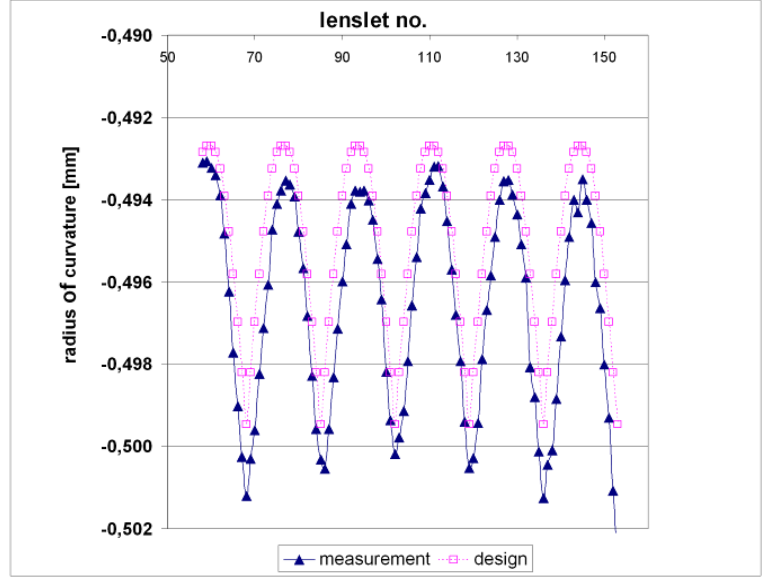
Figure 9. Chirped lens arrays: Design ( hollow squares) and measurement data ( full triangles) of lens radii across a row of